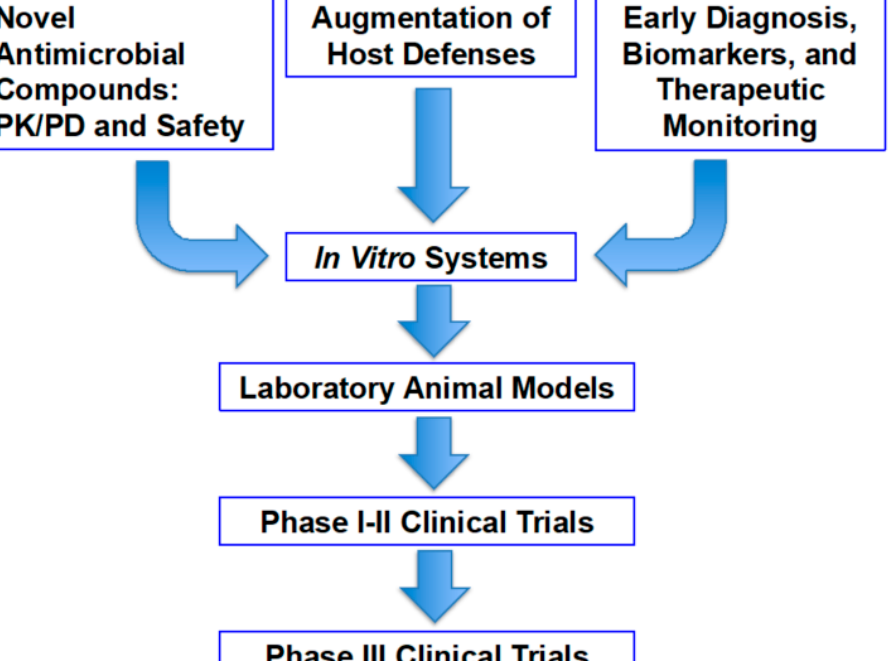
Figure 1. The strategies for translational research are achieved through a three-pronged approach that constitutes the pillars of management of immunocompromised